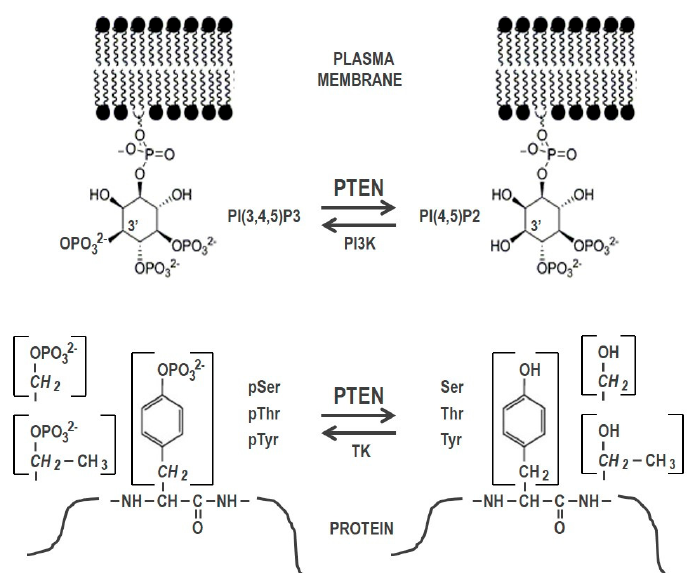
Figure 1. Schematic depiction of PTEN generic substrates. In the upper panel, dephosphorylation of PI(3,4,5)P3 at the plasma membrane is shown. In the bottom panel, protein dephosphorylation is shown, with the side chain of Ser, Thr, or Tyr amino acids in brackets. PI3K, phosphatidylinositol-4,5-bisphosphate 3-kinase; TK, tyrosine kinase.